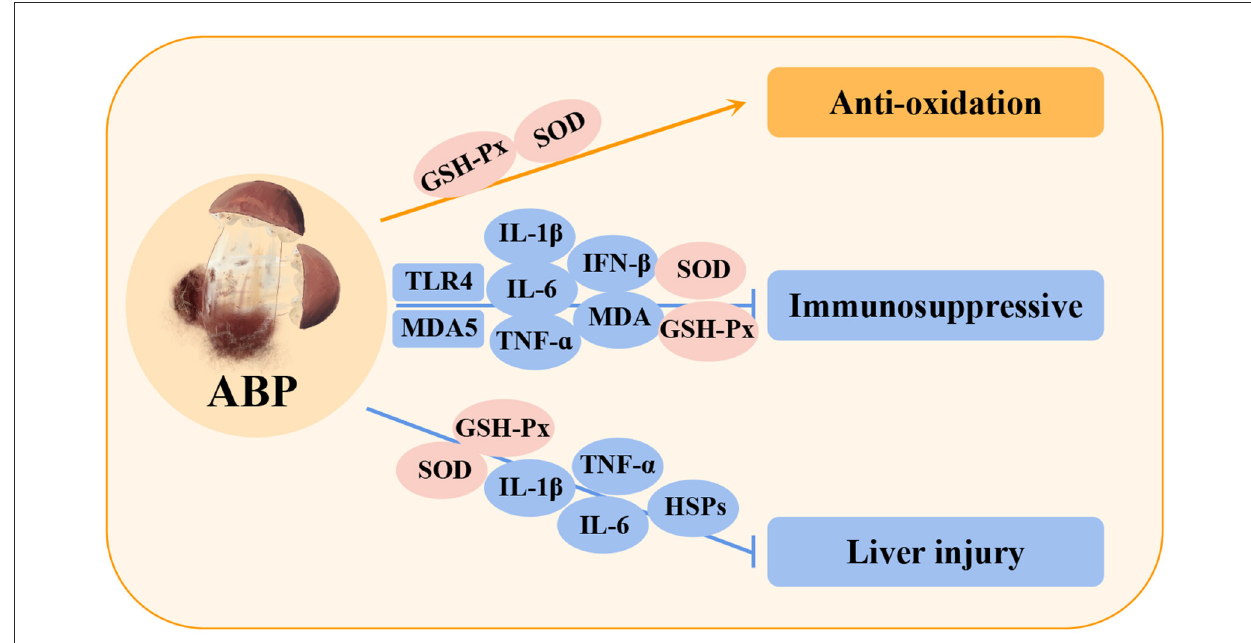
FIGURE7 Immunomodulatory and hepatoprotective effects of Agaricus blazei Murill polysaccharides (ABPs) in poultry. C4, complement component 4; IFN- β , interferon-beta; HSPs, heat shock